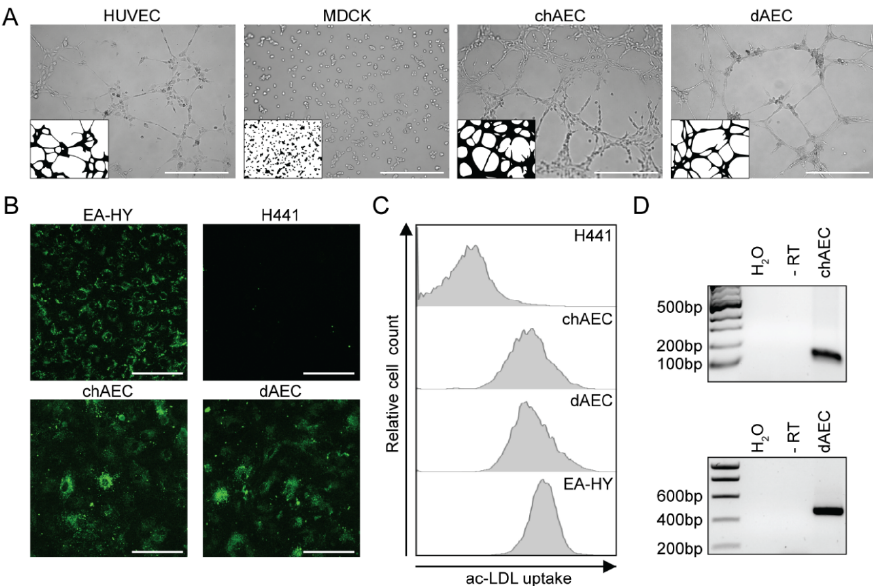
Figure 1. Endothelial cell characteristics of chicken and duck aortic endothelial cells. ChAEC and dAEC were isolated and passaged as described in the Materials and Methods section. ( A ) Representa- tive bright field microscopy pictures of a tube formation assay after 4 h performed with chAEC (p14) and dAEC (p15). Human endothelial cells (HUVEC, p10) and canine epithelial cells (MDCK, p54) were used as positive and negative controls, respectively. In each corner, a schematic representation of the formed structures is shown. The scale bar represents 500 µ m. Representative immunofluores- cence images ( B ) and flow cytometry histograms ( C ) showing uptake of Alexa Fluor ® 488-conjugated ac-LDL by chAEC (p15) and dAEC (p16) after 4 h of treatment. Human endothelial cells (EA-hy, p17) and human epithelial cells (H441, p19) were used as positive and negative controls, respectively. The scale bar represents 100 µ m. ( D ) RT-PCR for vWF expression on chAEC (p16) and dAEC (p17). The left lane is the DNA size marker; bp = base pairs. ‘-RT’ = samples where RNA was used as template as a control for genomic DNA